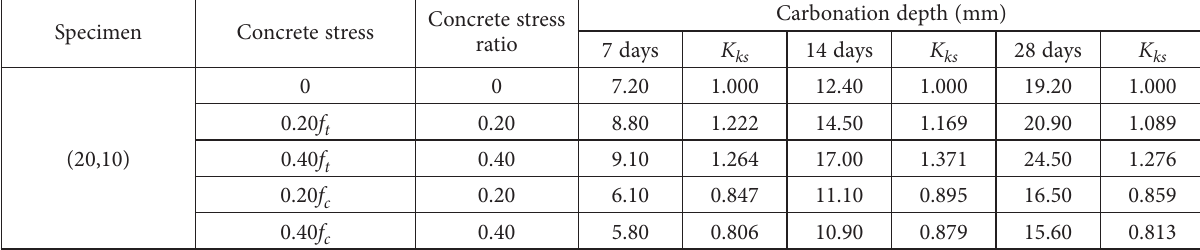
Table 8. Carbonation depths of specimens under different concrete stress conditions (data from Li et al., 2017b)